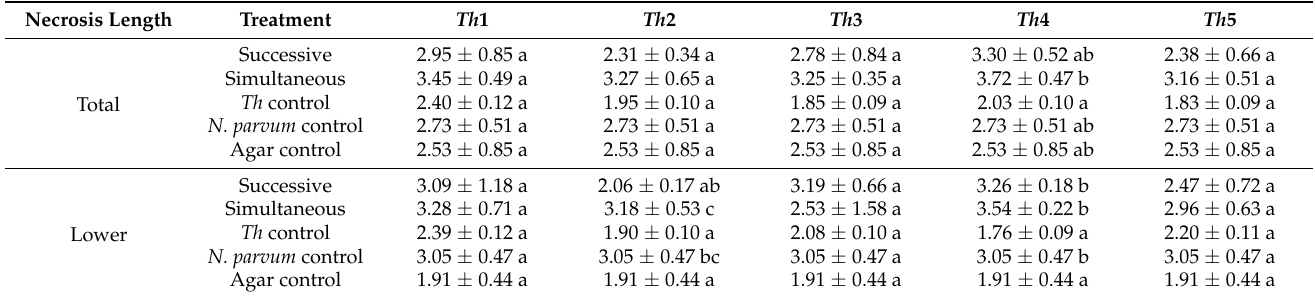
Table 5. Total necrosis and lower necrosis of grafted plants in cm (mean ± standard deviation) for each type of treatment (successive or simultaneous inoculation with N. parvum and T. harzianum , and controls with plant inoculated only with agar) for each T. harzianum